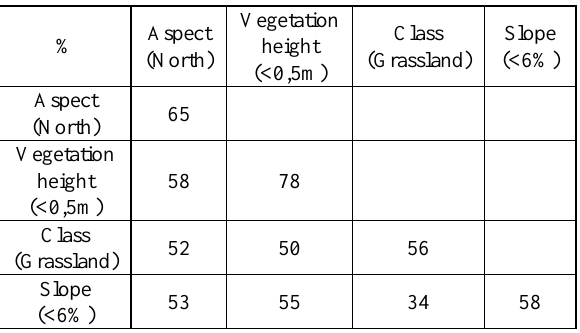
Table 1. Percentage of sheep positions after each dominant